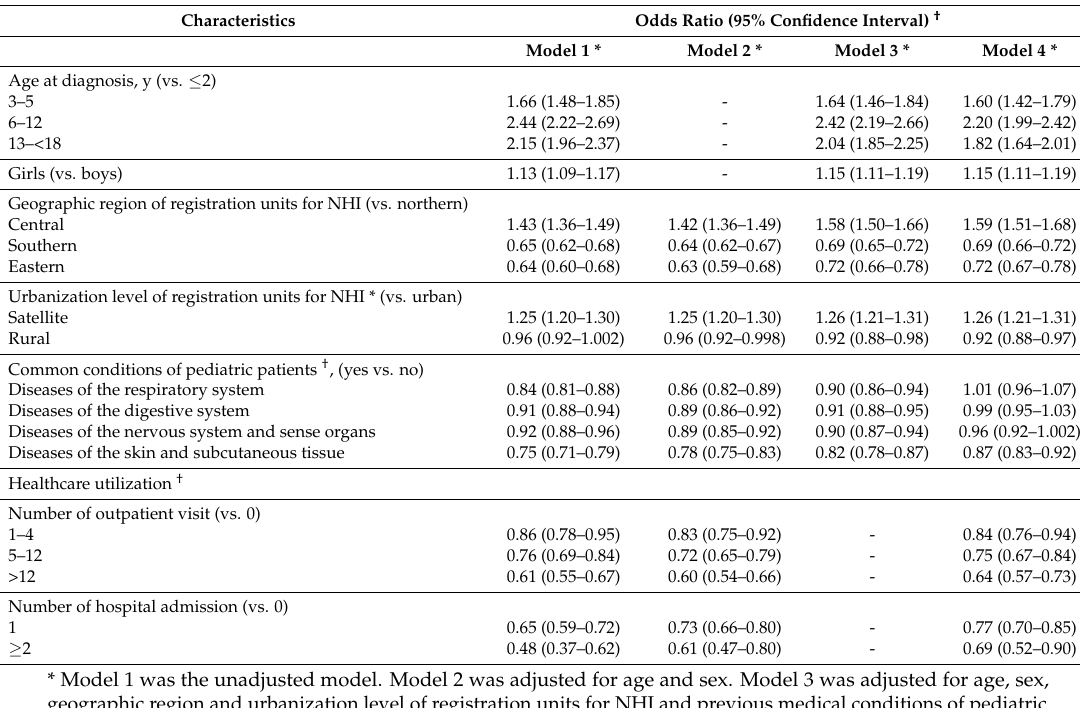
Table 3. Demographics and previous medical conditions associated with the use of traditional Chinese medical care as the first option for consultation in pediatric patients with the diagnosis of dislocations, sprains and